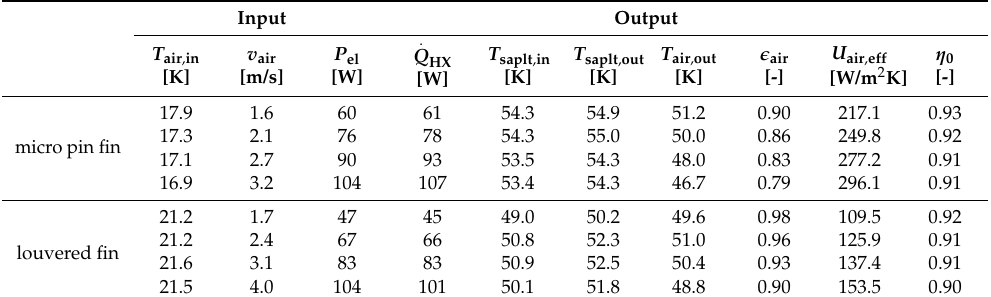
Table 4. Selection of experimentally determined data points for thermal performance evaluation. Input